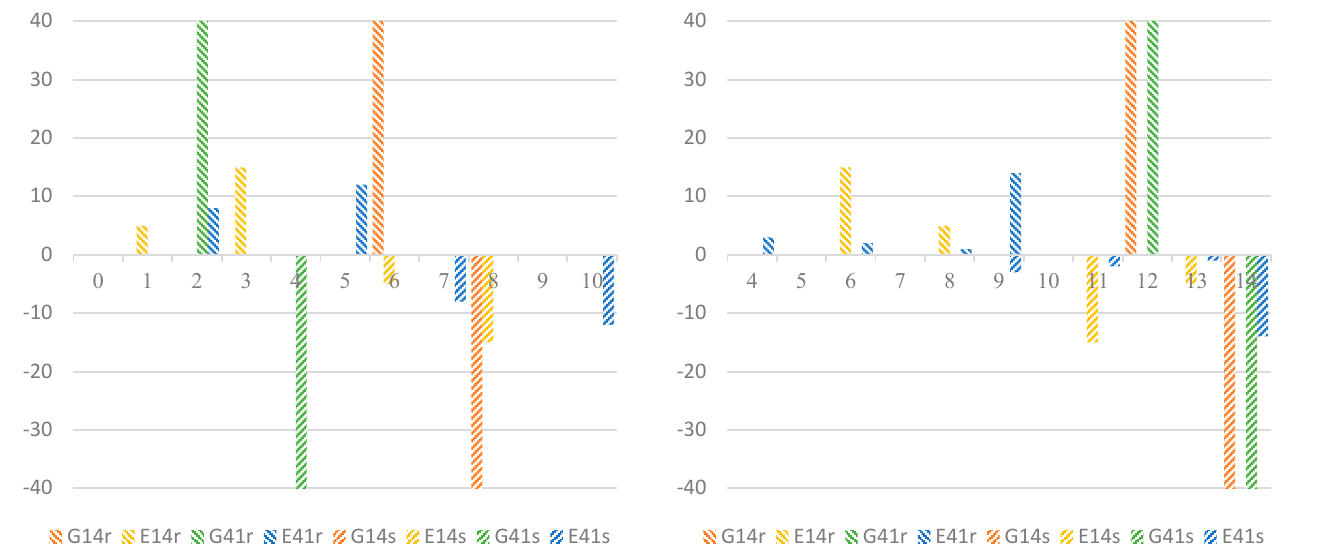
Figure 10. Path assignment of EVs of 2 tasks h (TN prior, T = 14).